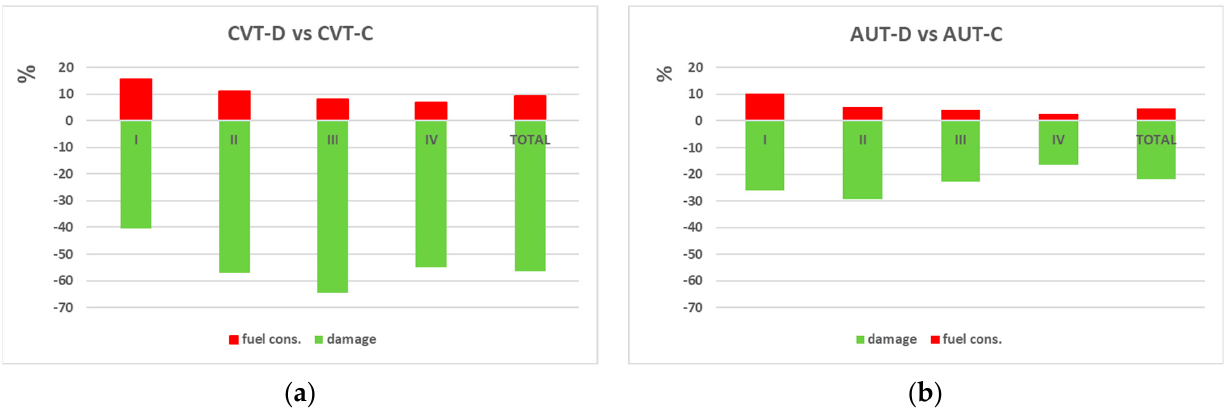
Figure 8. ( a ) Percentage difference in fuel economy (red bar) and kilometer damage (green bar) for the CVT-D powertrain compared to the CVT_C; ( b ) the same for the AUT-D powertrain compared to the AUT_C.